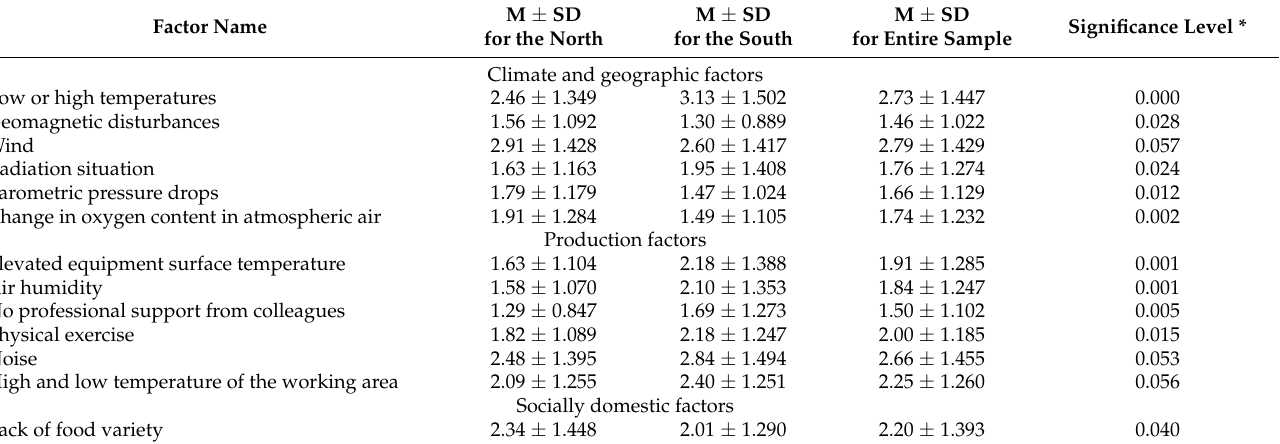
Table 2. Statistically significant differences according to univariate tests in the subjective assessment of the discomfort of climatic, geographical, industrial and social factors among FIFO personnel in the north and south of the Russian Federation (on a five-point scale, where 5 is the most uncomfort- able